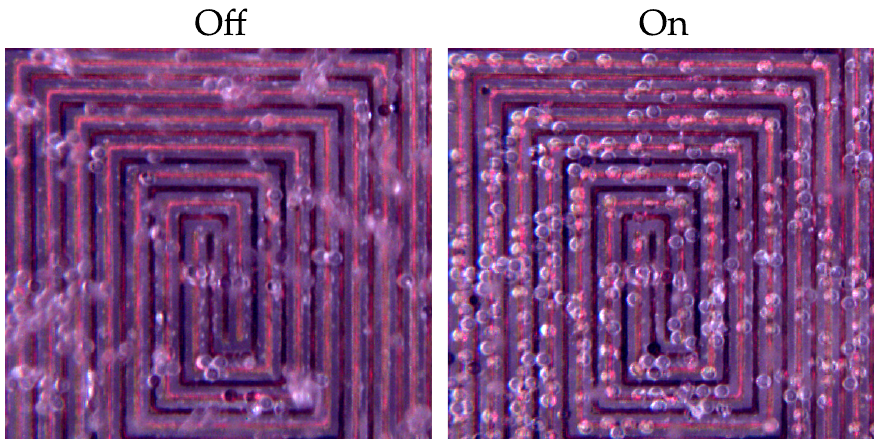
Figure 17. Microscope images of MP spheres over the DEP electrode array. When no voltage is applied, the MPs are suspended above the device. When voltage is applied, the MPs are attracted to the